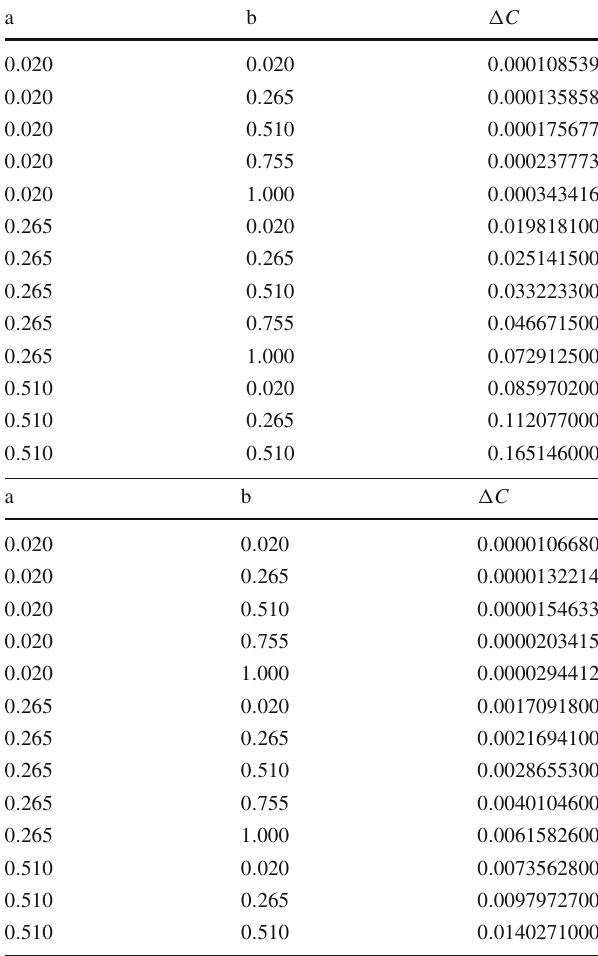
Table 2 Deviation (cid:2) C of Kerr-Sen-like black hole with k = l = 0 . 1. The upper one is for the inclination angle θ = 90 ◦ and the lower one is for the inclination angle θ = 17 ◦ a b (cid:2)